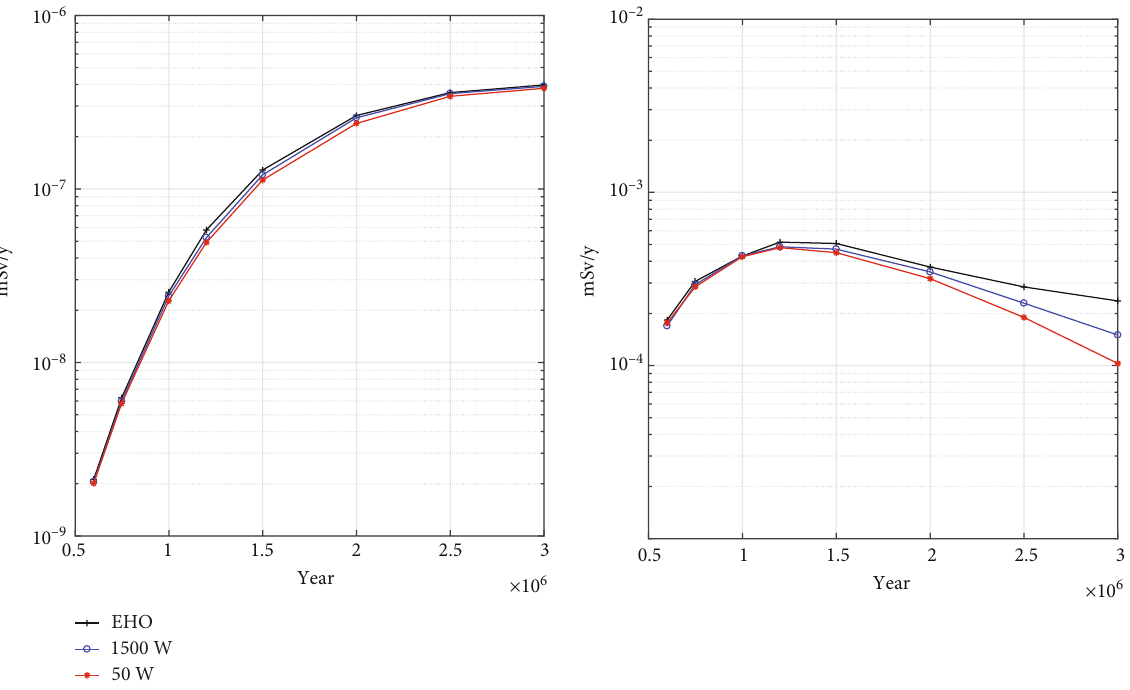
Figure 14: Annual dose at hypothetical well ( Z = − 60 m , R = 60 m ) for varying e ff ective di ff usion coe ffi cient (10 -10 m 2 /s (a) and 5 × 10 10 m 2 /s (b). Borehole depth is 500 m and k = 10 − 16 m 2 .